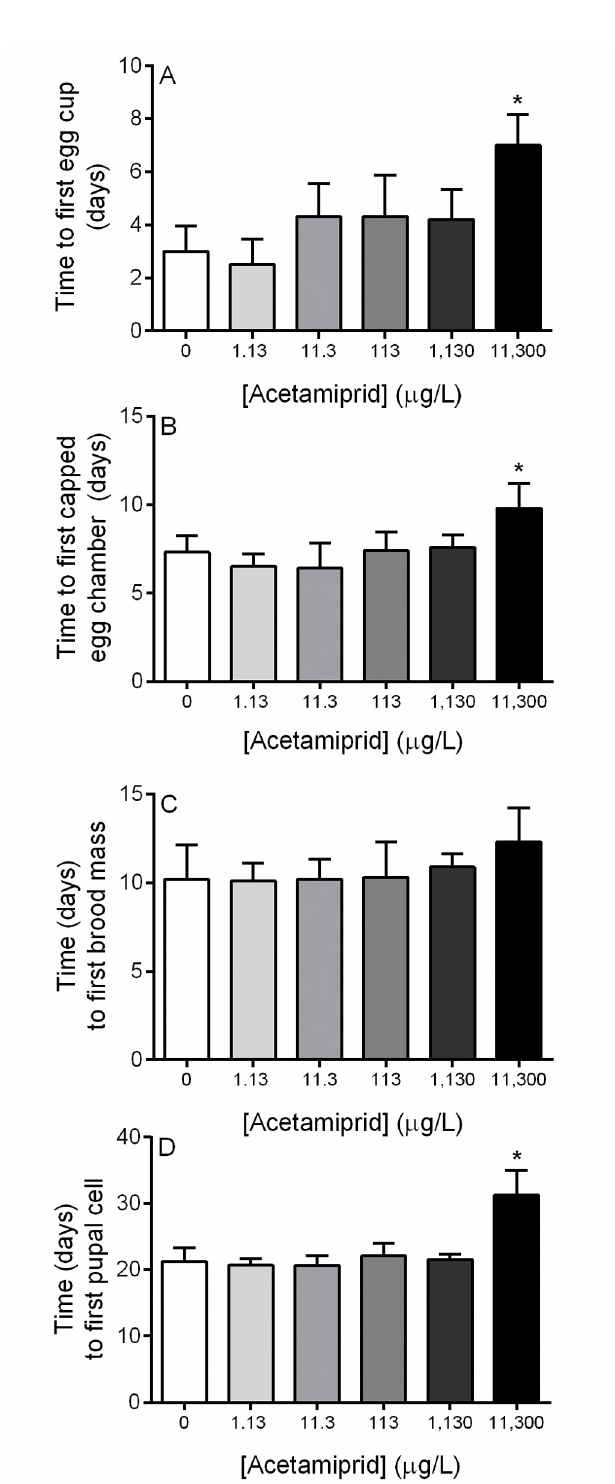
Fig 2. B . impatiens microcolony nest development with acetamiprid exposure. ( A ) Time to first egg cup. ( B ) Time to first capped egg chamber. ( C ) Time to first brood mass. ( D ) Time to first pupal cell. Observations were conducted daily for the duration of the experiment. Data shown as mean ± SD (n = 10). � denotes p < 0.05.